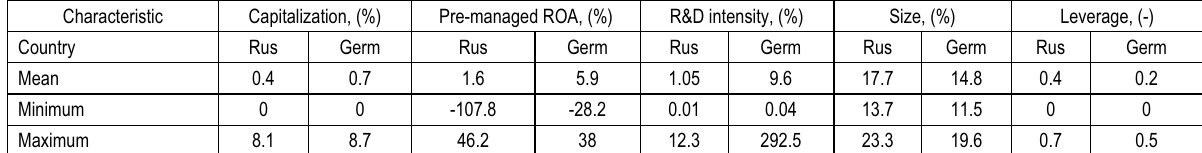
Table 3. Comparative descriptive statistics of the sample